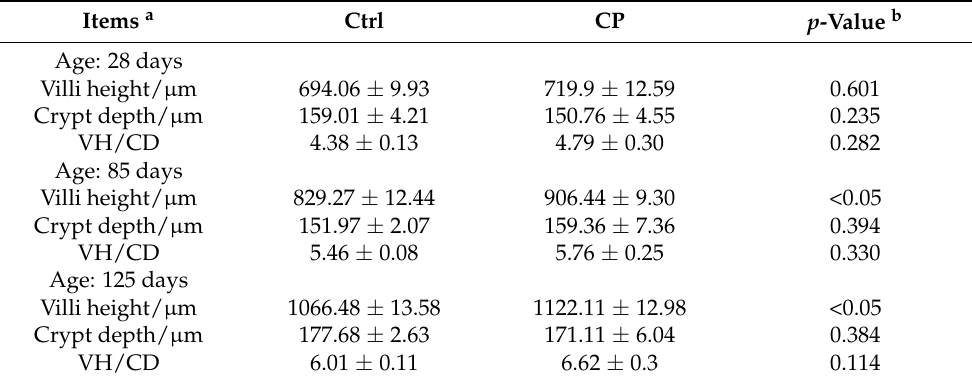
Figure 1. Effects of compound probiotics on the morphological structure in the duodenum mucosa of ducks. Ctrl, basal diet, CP, basal diet supplemented with 0.15% compound probiotics. The first and third columns of the pictures are scaled to 100 µ m, and the second and fourth columns of the pictures are scaled to 50 µ m. Table 7. Effects of compound probiotics on the morphological structure in the jejunum mucosa of ducks.